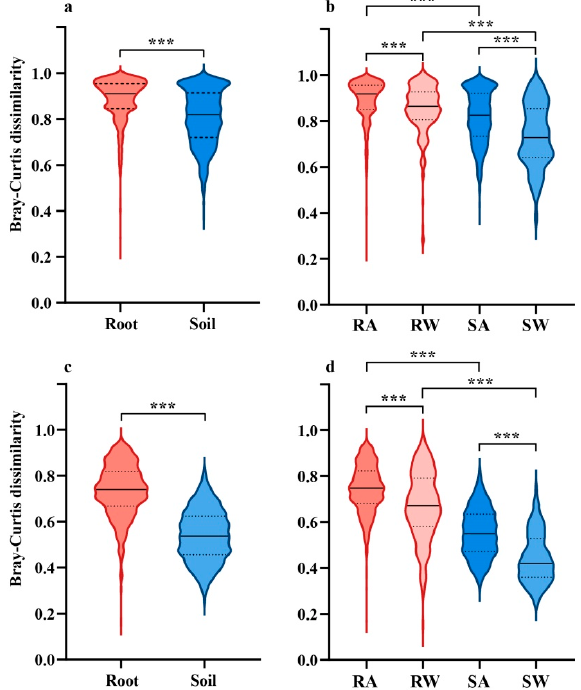
Figure 10. Dissimilarities of microbial communities in rhizosphere soil and roots based on Bray–Curtis dissimilarity. The fungal community ( a ) and bacterial community ( c ) dissimilarities between roots and soil in all samples. The fungal community ( b ) and bacterial community ( d ) dissimilarities separately calculated among elevations and at a particular elevation. RA: Root communities among elevations, RW: Root communities at a particular elevation, SA: Soil communities among elevations, SW: Soil communities at a particular elevation. Mann–Whitney U tests were used to evaluate differences in the abundance of rhizosphere soil and roots. Significant difference: *** p ≤ 0.001.